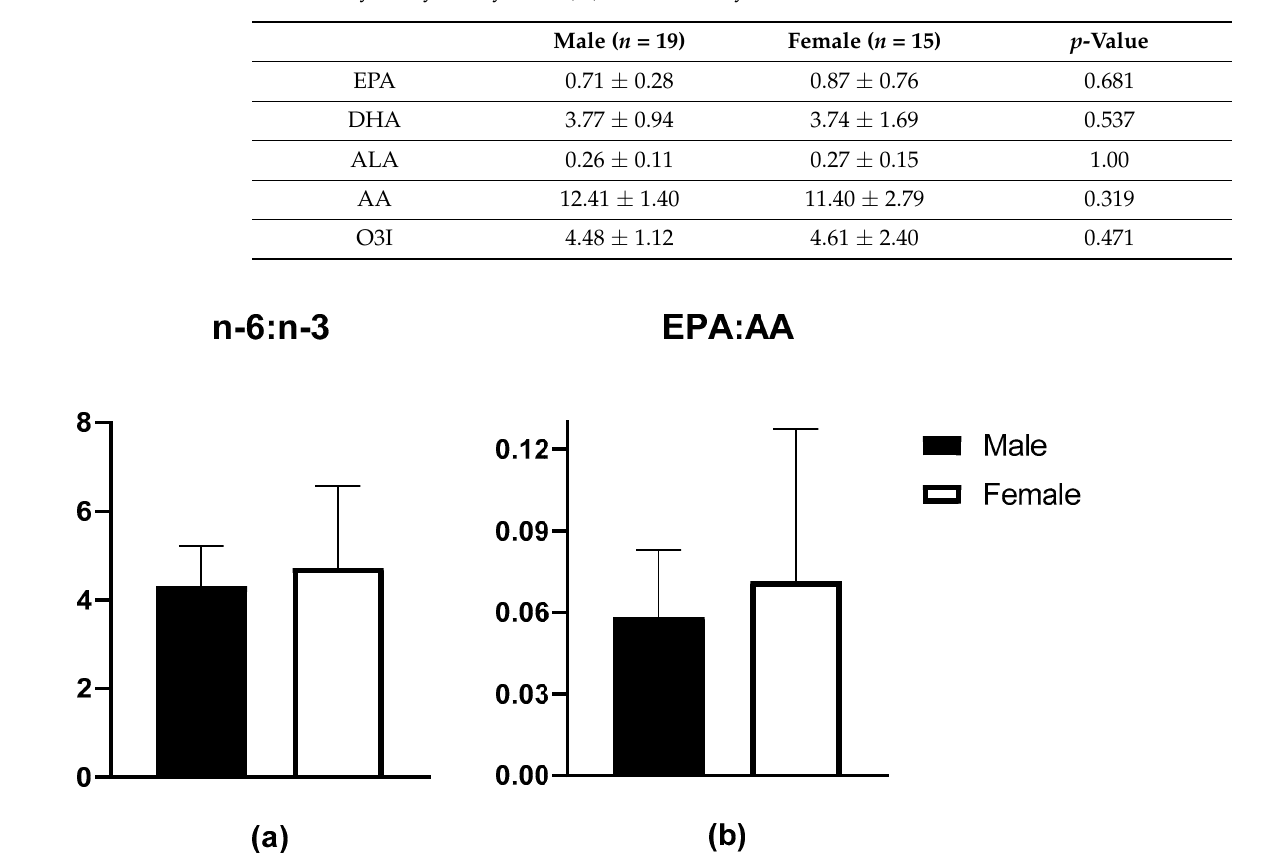
Table 2. Erythrocyte fatty acids (%) distributed by sex.